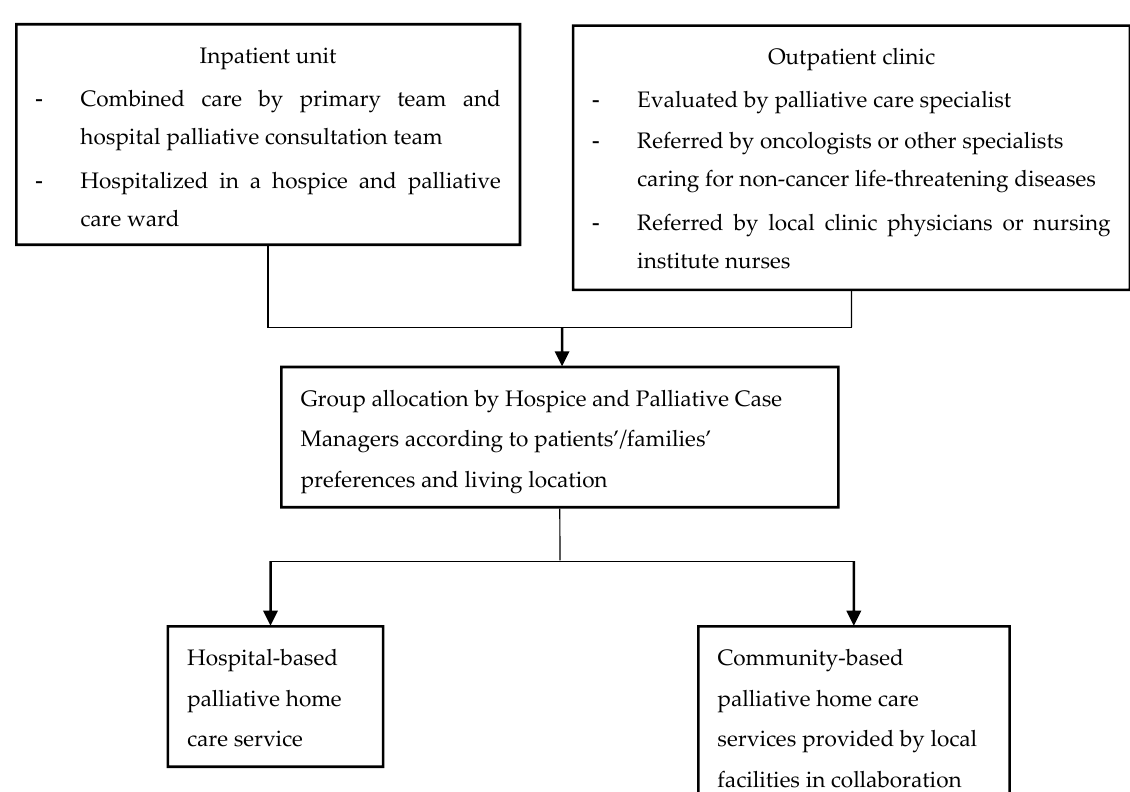
Figure 1. Study group allocation flowchart.